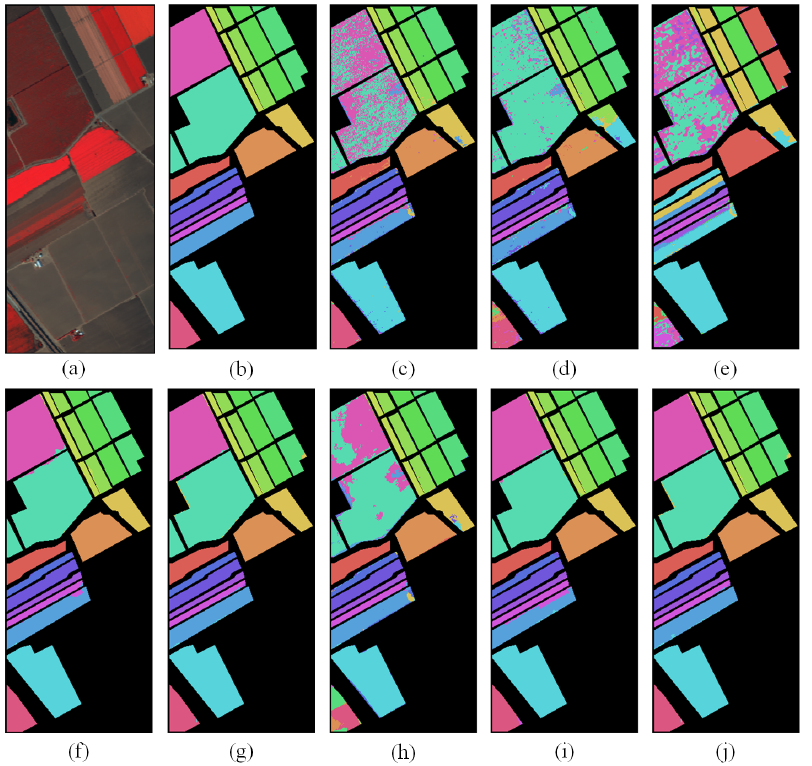
Figure 7. Classification maps of different methods on Salinas dataset; ( a ) Composite RGB image. ( b ) Groundtruth map. ( c ) SVM; ( d ) 3D-CNN; ( e ) 1D+2D; ( f ) GCN-M; ( g ) KDCDWBF; ( h ) STSE_DWLR; ( i ) SGL; ( j ) MSGLAMS (Proposed).